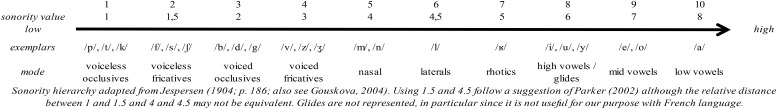
Sonority scale (adapted from Jespersen, 1904; p. 186; also see Gouskova, 2004).